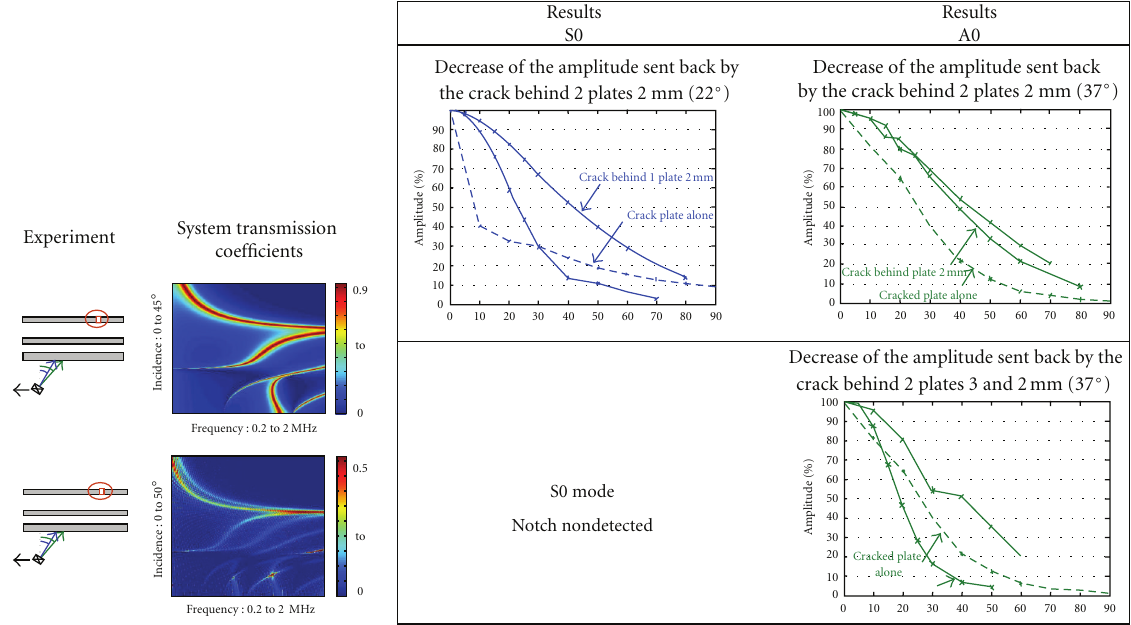
Figure 23: The results of three plates (solid lines) are compared in terms of the relative amplitude with the results of one and two plates (dashed lines).